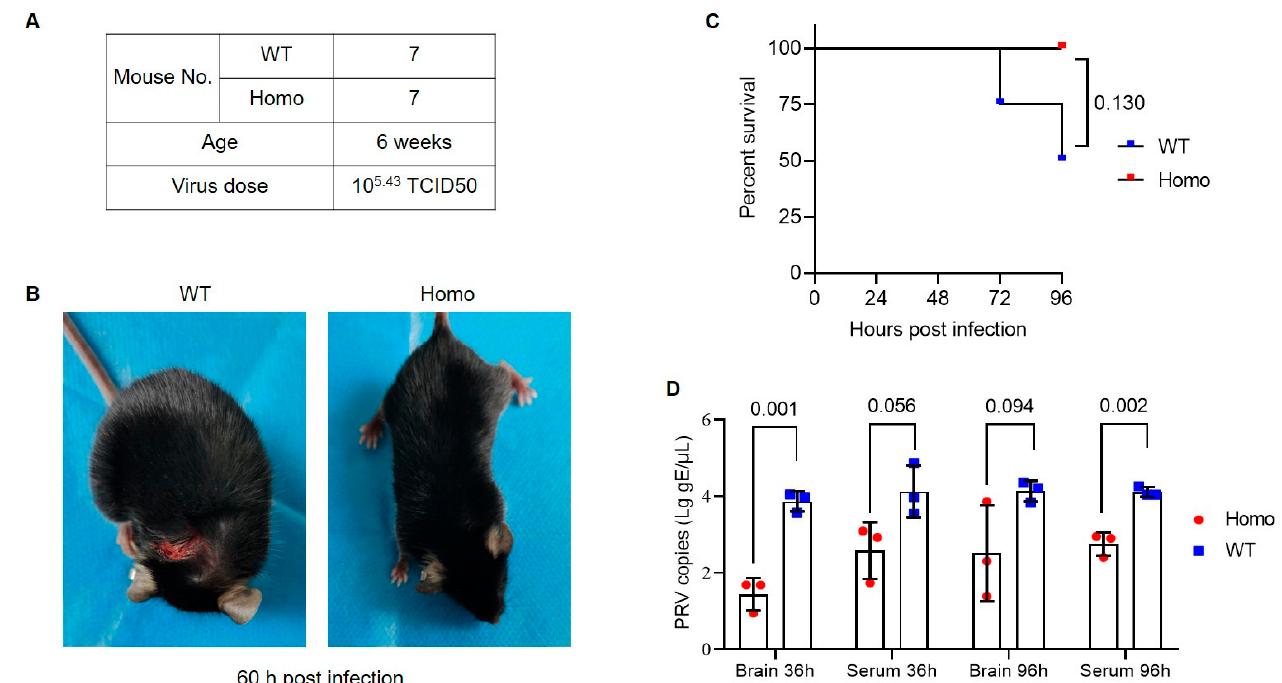
Figure 2. Viral challenge experiment 1 in nectin1 (F129A) mutant mice. ( A ) Experimental groups and virus dose for PRV challenge in mice. ( B ) Typical symptoms present in PRV-infected mice. A WT mouse showed body incoordination and severe wound in the neck because of scratching of the viral injection site at 60 h after challenge (left), whereas no symptoms were observed in nectin1 (F129A) homozygous mutant mouse (right). ( C ) Survival curve for nectin1 (F129A) homozygous mutant and WT mice after PRV challenge within 96 h. Four mice in each group were used for analysis of survival curve. The other three mice in each group were sacrificed to analyze viral infection level in various tissues at 36 h. ( D ) PRV viral loads at 36 h and 96 h in brain and serum by qPCR quantification of PRV gE gene. All data are presented in mean ± standard deviation. Statistically significant differences between mutant and WT groups are indicated by p -values, analyzed with Gehan–Breslow–Wilcoxon test and unpaired t -test for survival curve and viral copies, respectively. Homo, homozygous nectin1 (F129A) mutant mice; WT, wild-type